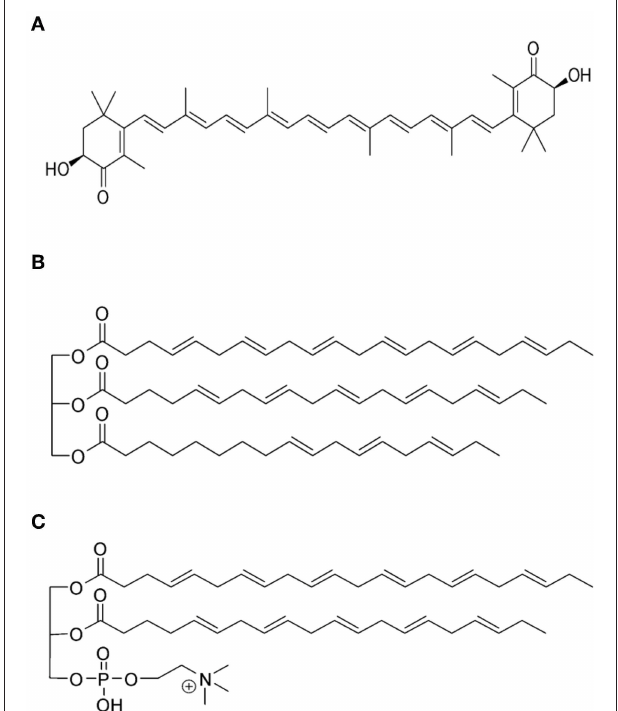
FIGURE 1 | (A) The molecular structure of the natural fat-soluble antioxidant astaxanthin that provides KO with the blood reddish color. (B,C) illustrate the main difference in the ω -3 PUFA composition between FO and KO. In (B) , an example on the typical presence of the ω -3 PUFAs docosahexaenoic acid (DHA; 22:6 n-3) and eicosapentaenoic acid (EPA; 20:5 n-3) in the form of triacylglycerols is given; whereas (C) shows that these ω -3 PUFAs are typically conjugated to the glycerol moieties of phospholipids in KO. These molecular structures were drawn with ChemBioDraw Ultra version 12 (PerkinElmer Informatics, Waltham, MA,